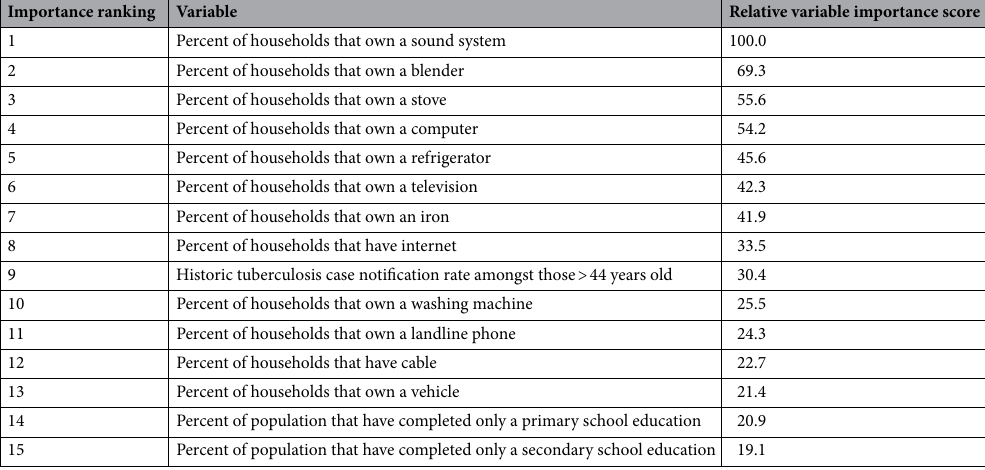
Table 3. Top 15 most important variables for predicting tuberculosis screening yield (Approach 2a, CART with continuous outcome; n = 73 neighborhoods).